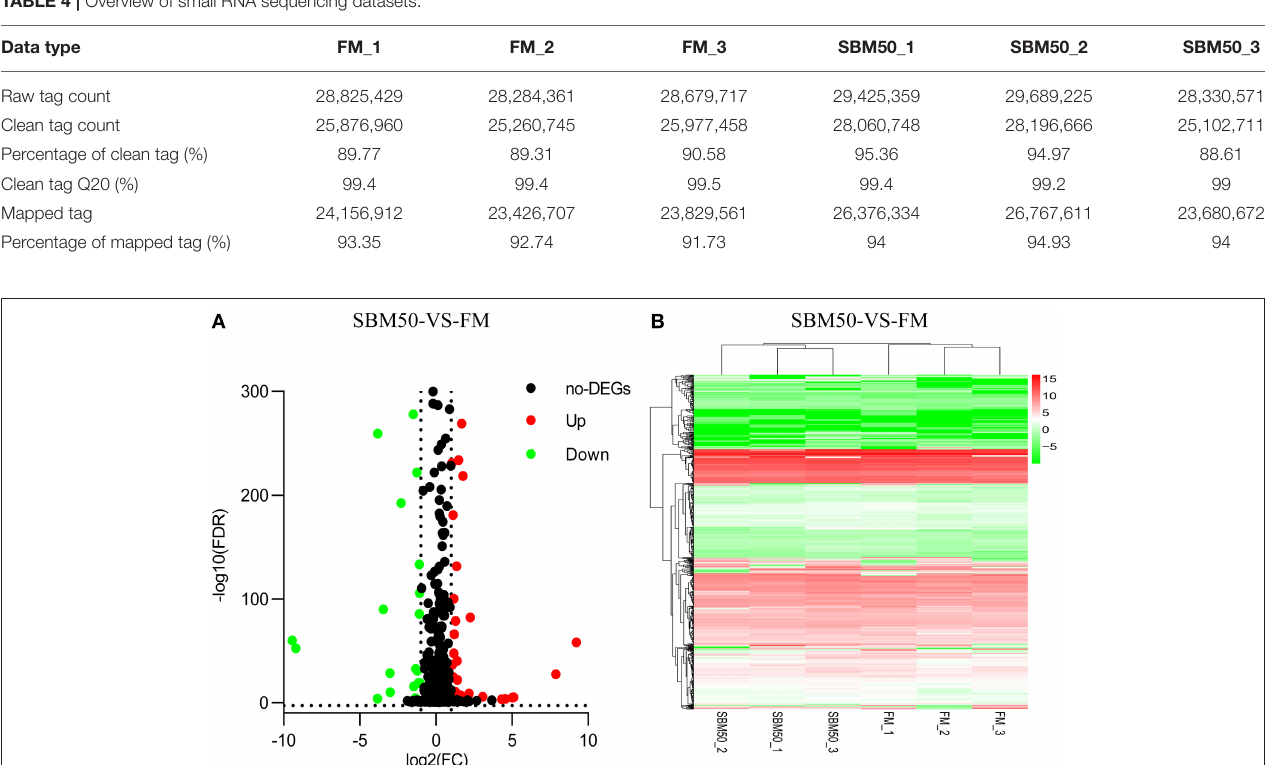
FIGURE 4 | Volcano plot (A) and hierarchical cluster (B) analysis of differentially expressed miRNAs (DEmiRNAs) in the FM and SBM50 groups. (A) Each point in the figure indicates a gene, the horizontal axis represents the numerical value of gene expression, and the vertical axis represents the negative logarithm of P -value-FDR. Red and green dots indicate the upregulation and downregulation of DEmiRNAs, respectively. Black dots indicate no differential expression of genes. (B) The color indicates the level of gene expression. Red and green colors represent the high and low expression of genes,